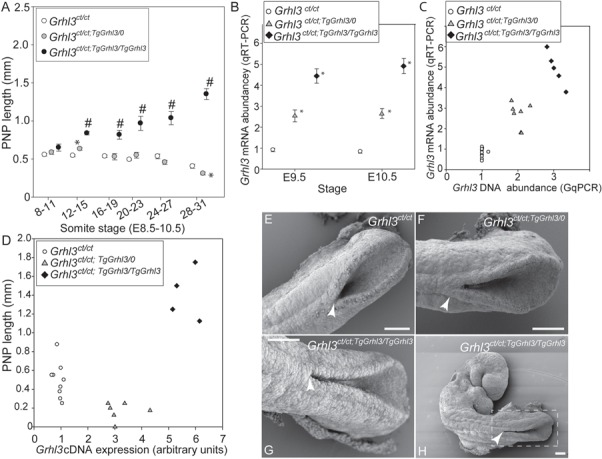
Excess expression of Grhl3 results in spinal NTDs owing to failure of PNP closure. (A) Among litters from Grhl3ct/ct;TgGrhl3/0 matings analysed at E8.5–10.5, the PNP was significantly enlarged among Grhl3ct/ct;TgGrhl3/TgGrhl3 embryos (n = 64) from the 12–15 somite stage onwards (#, significant difference from both other genotypes, P < 0.001). PNP closure was normalized in Grhl3ct/ct;TgGrhl3/0 embryos (n = 123) compared with Grhl3ct/ct littermates (n = 176) at 28–31 somites (*, significantly different from Grhl3ct/ct, P < 0.001). Mean ± SEM values; n = 4–77 embryos/genotype/stage (see Supplementary, Fig. S2
for plot of individual data). (B) Abundance of Grhl3 mRNA varies significantly with genotype at E9.5 and E10.5 (*P < 0.0001 ANOVA; Holm-Sidak pairwise analysis). For context, we previously found that Grhl3 expression in ct/ct embryos at E10.5 was ∼50% of that in partially congenic wild-type (+ct) embryos (11). (C) Analysis of individual embryos at E10.5 (28–29 somites) shows that increased abundance of Grhl3 genomic DNA (in transgenic embryos) results in gene dosage-dependent increase in Grhl3 mRNA expression. qG-PCR signal corresponds to 2, 3 and 4 copies of Grhl3 in ct/ct, hemizygous and homozygous transgenics, respectively. (D) Moderate overexpression of Grhl3 normalizes PNP closure in individual Grhl3ct/ct;TgGrhl3/0 embryos, compared with Grhl3ct/ct, whereas excess expression prevents PNP closure, in Grhl3ct/ct;TgGrhl3/TgGrhl3. (E–H) Scanning electron micrographs at E9 (13 somite stage) show typical appearance of the closing PNP. Neural folds are elevated and apposed in all three genotypes (E–G) but failure of closure progression is already apparent in Grhl3ct/ct;TgGrhl3/TgGrhl3 embryos (G,H), leaving a narrow unclosed region (compare region adjacent to white arrow E–H). Scale bars represent 0.1 mm.